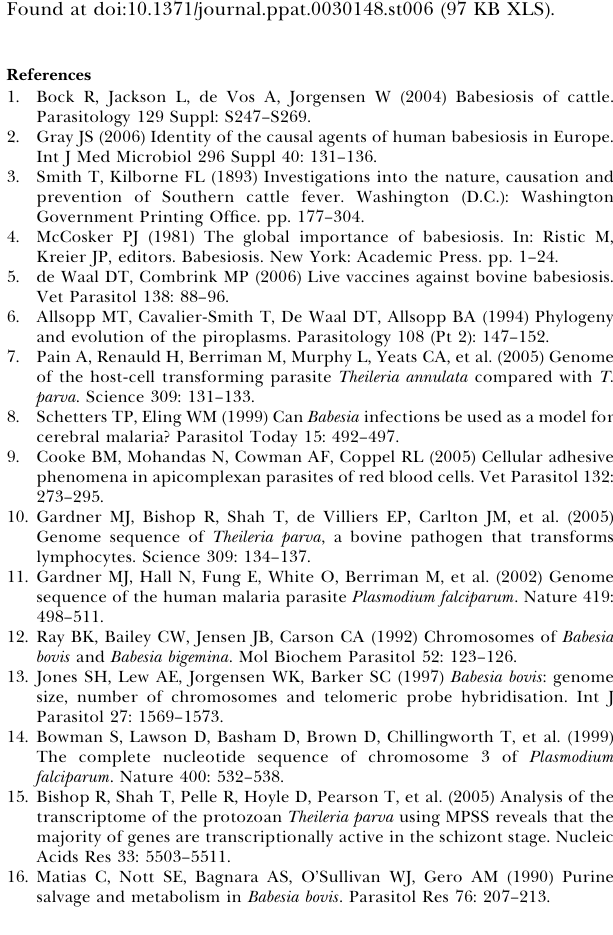
Figure S5. Venn Diagram Showing Number of Genes in Overlapping COGs between B. bovis , T. parva , and P. falciparum Found at doi:10.1371/journal.ppat.0030148.sg005 (14 KB PDF). Figure S6. Example of Microsynteny between B. bovis and T. parva The T. parva p67 locus is diagrammed in the middle row, with the corresponding B. bovis locus shown on the top row, and the T. annulata SPAG-1 locus diagrammed on the bottom row. Genes with sequence identity between species are connected by shaded gray lines. The gene highlighted with pink was used to identify the syntenic locus. The p67 gene is indicated. Found at doi:10.1371/journal.ppat.0030148.sg006 (52 KB PDF). Table S1. Transporters Table S2. Characteristics of Apicomplexan Plastids Table S3. Nuclear Encoded Genes Potentially Targeted to the Apicoplast Table S4. Characteristics of ves1 Sequences Table S5. CDS common to B. bovis , T. parva , and P. falciparum Found at doi:10.1371/journal.ppat.0030148.st005 (728 KB XLS). Table S6. CDS Unique to B. bovis